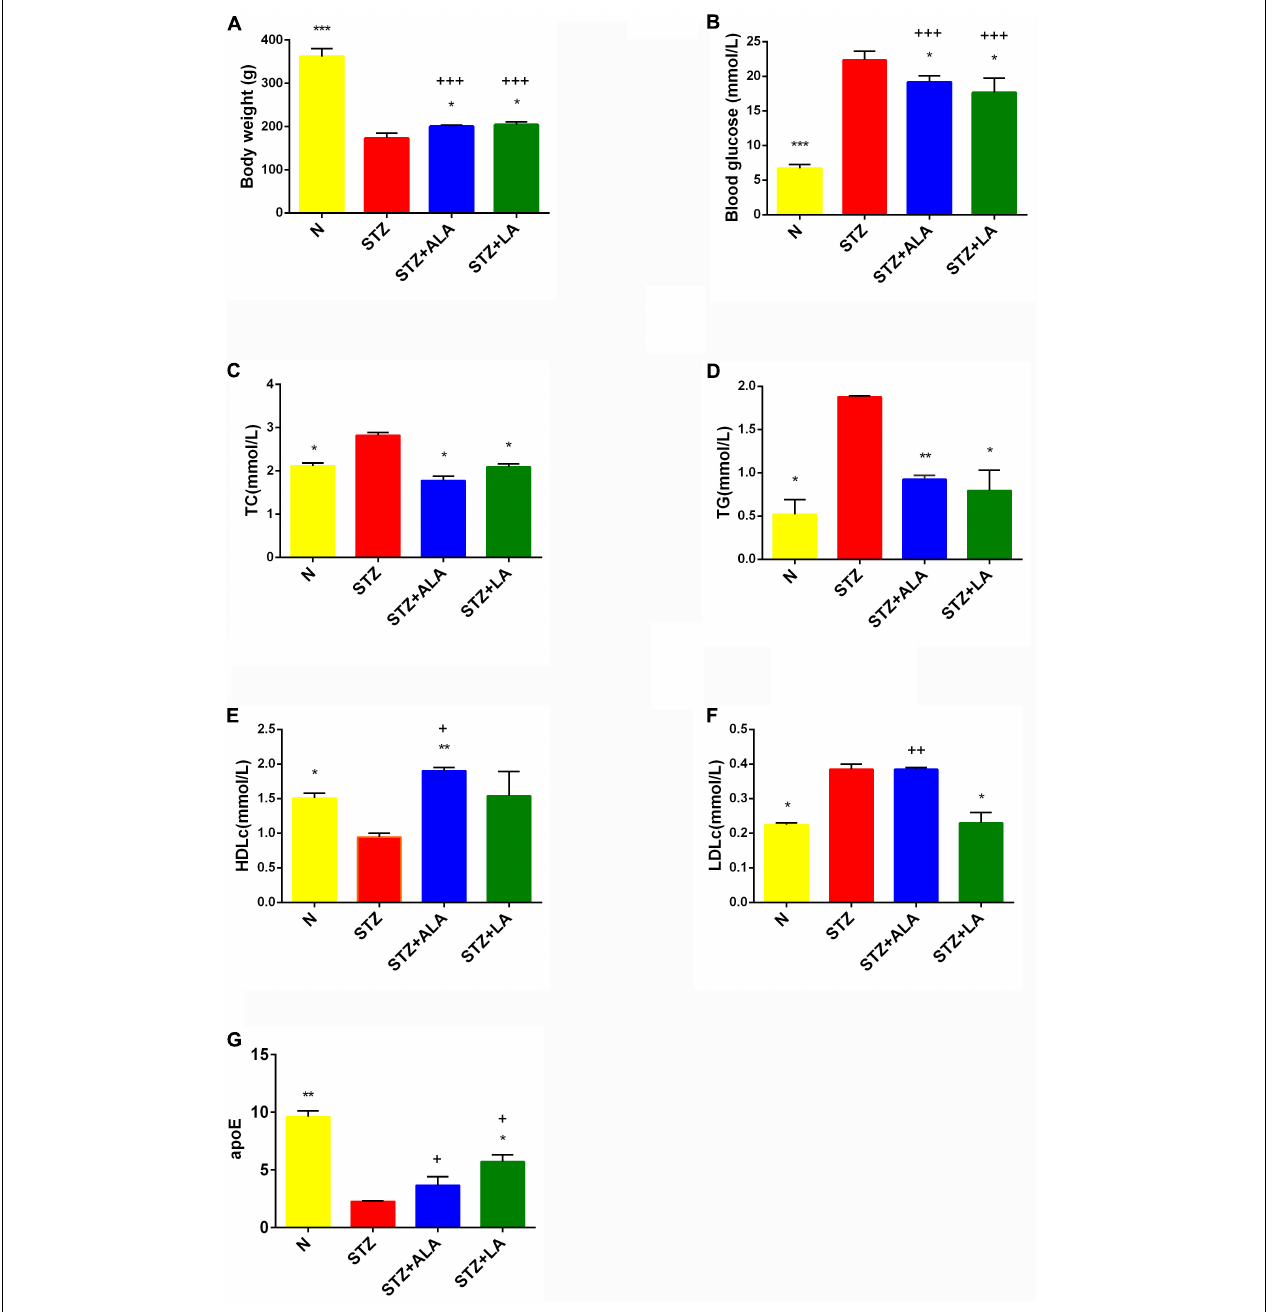
FIGURE 2 | Body weight (A) , blood glucose (B) , and lipids status (C–G) in the plasma of experimental animals. All values are expressed as mean ± SEM ( n =5). Comparisons were performed using one-way ANOVA with Tukey’s post hoc test. * versus STZ-treated group. * p ≤ 0.05, ** p ≤ 0.01, *** p ≤ 0.001. + P ≤ 0.05, ++ P ≤ 0.01, +++ P ≤